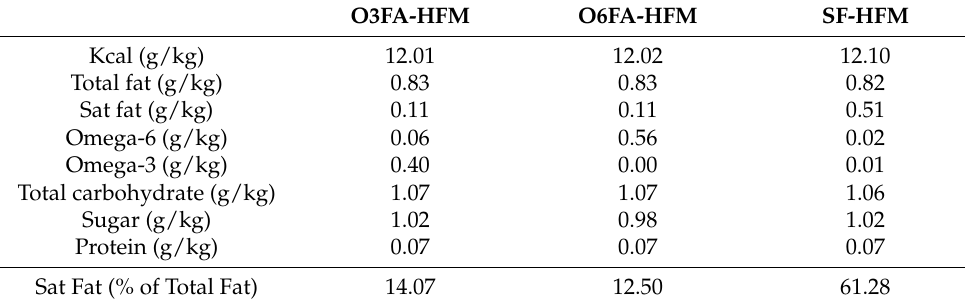
Table 1. Nutritional information for each HFM